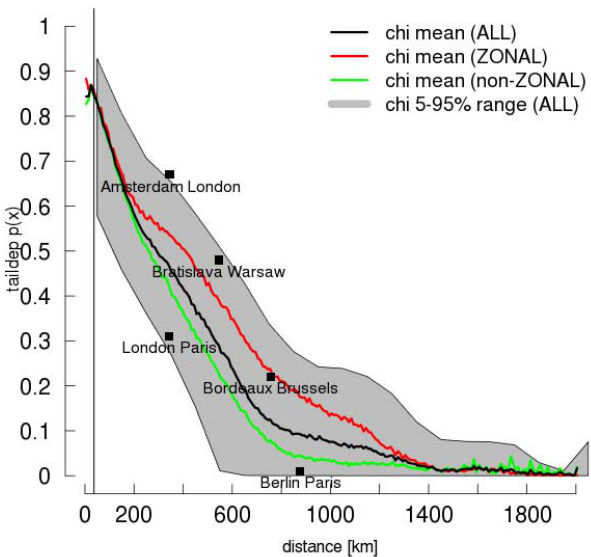
Fig. 4. Tail dependence χ as a function of distance between CRESTA centroids and orientation. Zonal CRESTA pairs are de- fined to have bearing angle between 90 and 120 degrees. Black vertical line (shown at x = 30km) shows mean CRESTA grid spac-